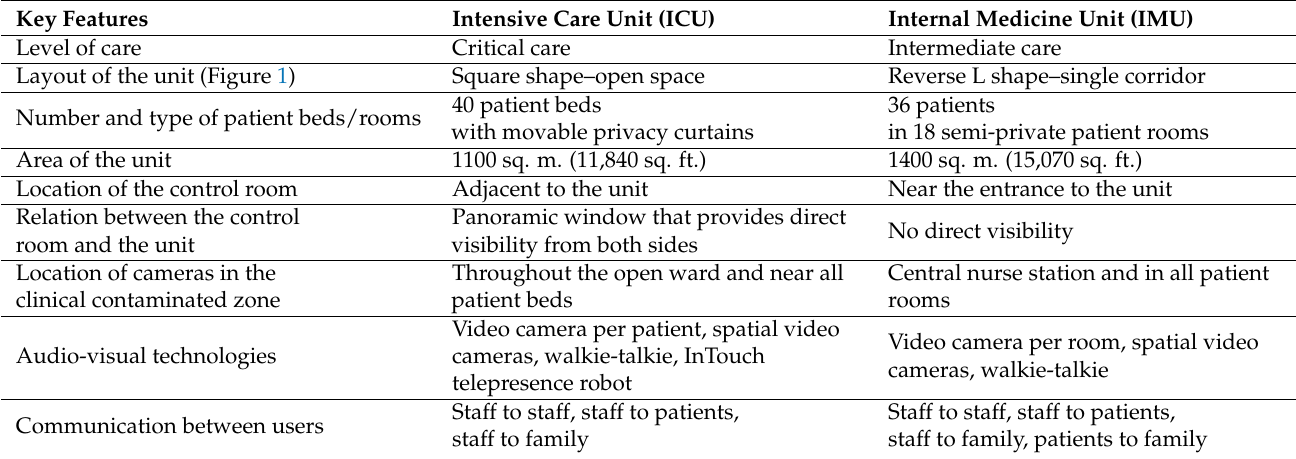
Table 1. Key Features of inpatient telemedicine in the COVID-19 units at the Sheba Medical